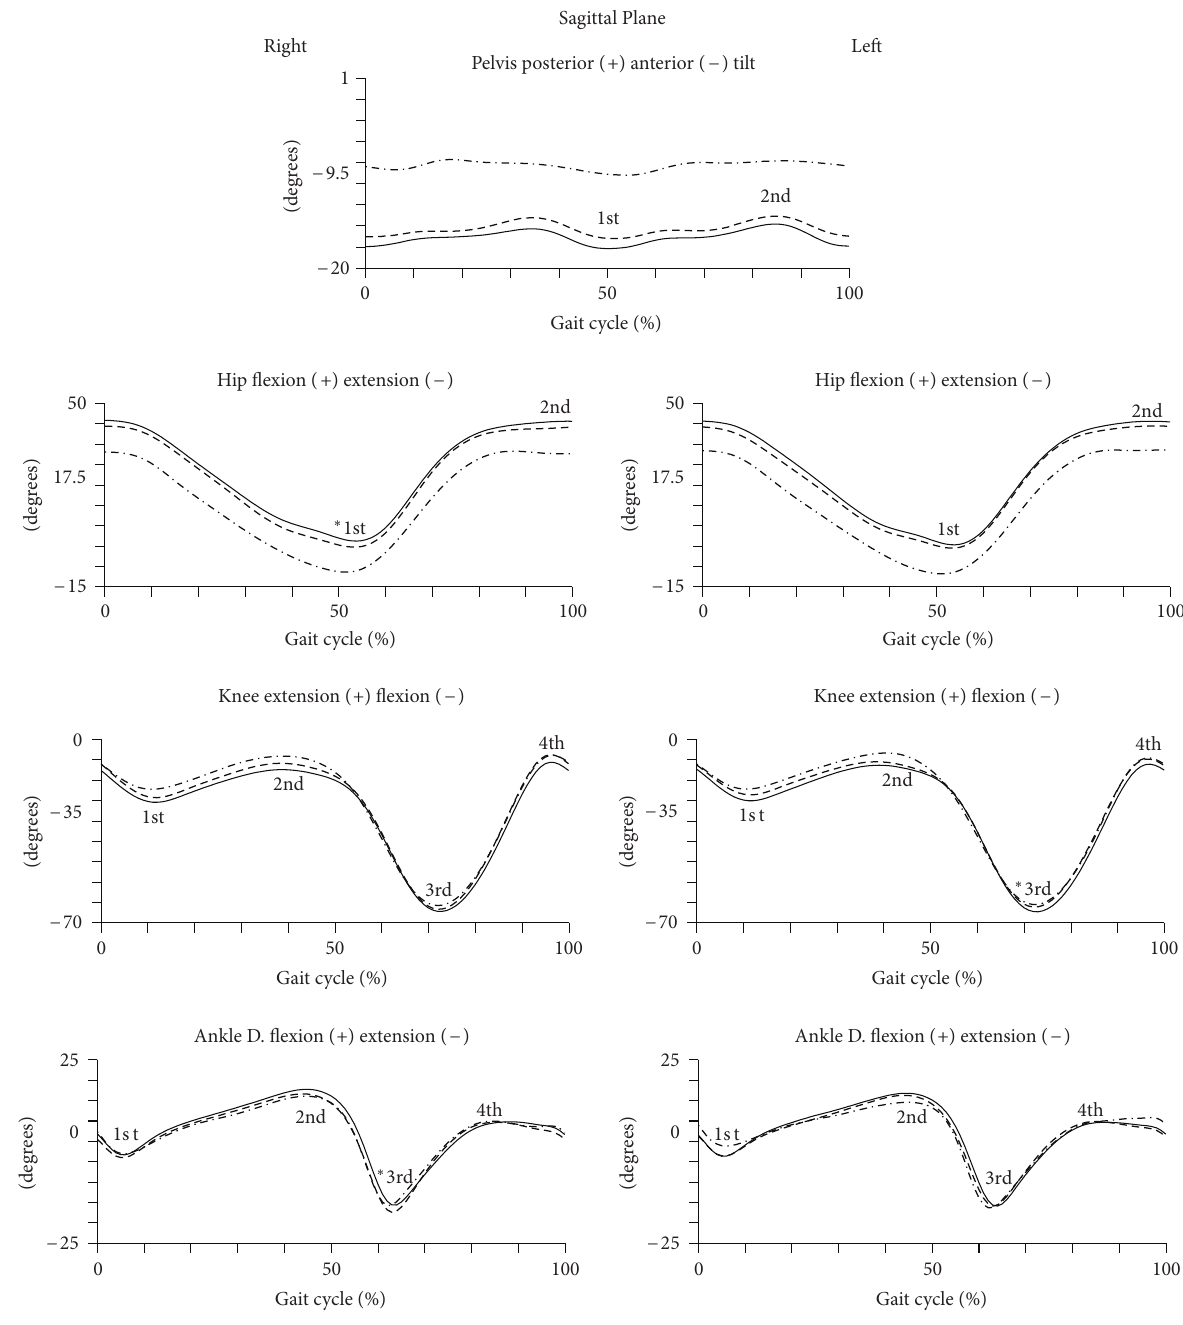
Figure 2: Kinematic parameters (sagittal plane) of gait of pregnant women in the later stages of second trimester (dashed line) and third trimester (solid line) and of nulliparous controls (dot line). Mean joint angles of the pelvis, hip, knee, and ankle, for right and left lower limbs, in degrees. The curve peaks are indicated by numbers: first, second, third and fourth and ( ∗ ) points the significant differences. ( 𝐹 = 12.876 ; 𝑃 = 0.001 ; power = 0.287). In the ankle there were no significant changes in angular